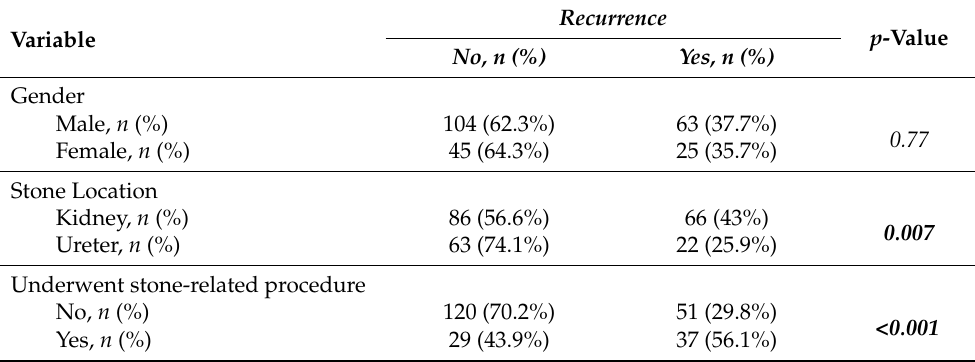
Table 2. Association between categorical variables and stone recurrence, univariate analysis. Analysis in this table was conducted using Fisher’s exact test ( n = number). Boldface indicates statistically significant factors.